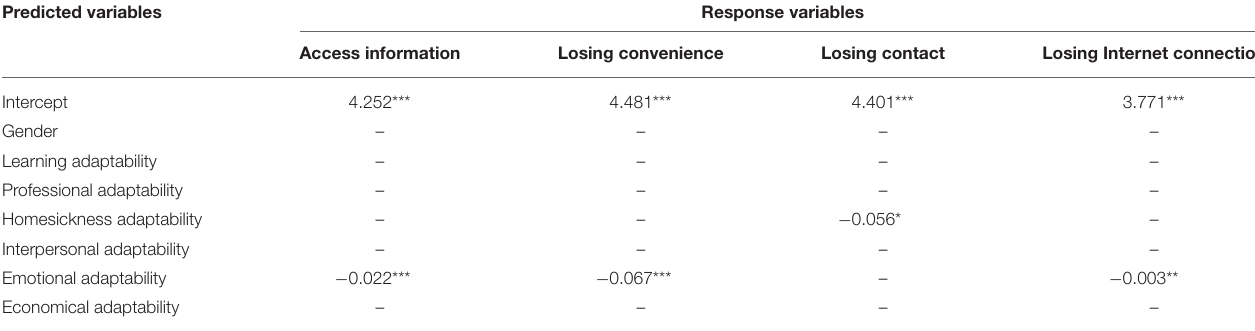
TABLE 3 | Lasso regression model of nomophobia and adaptability.